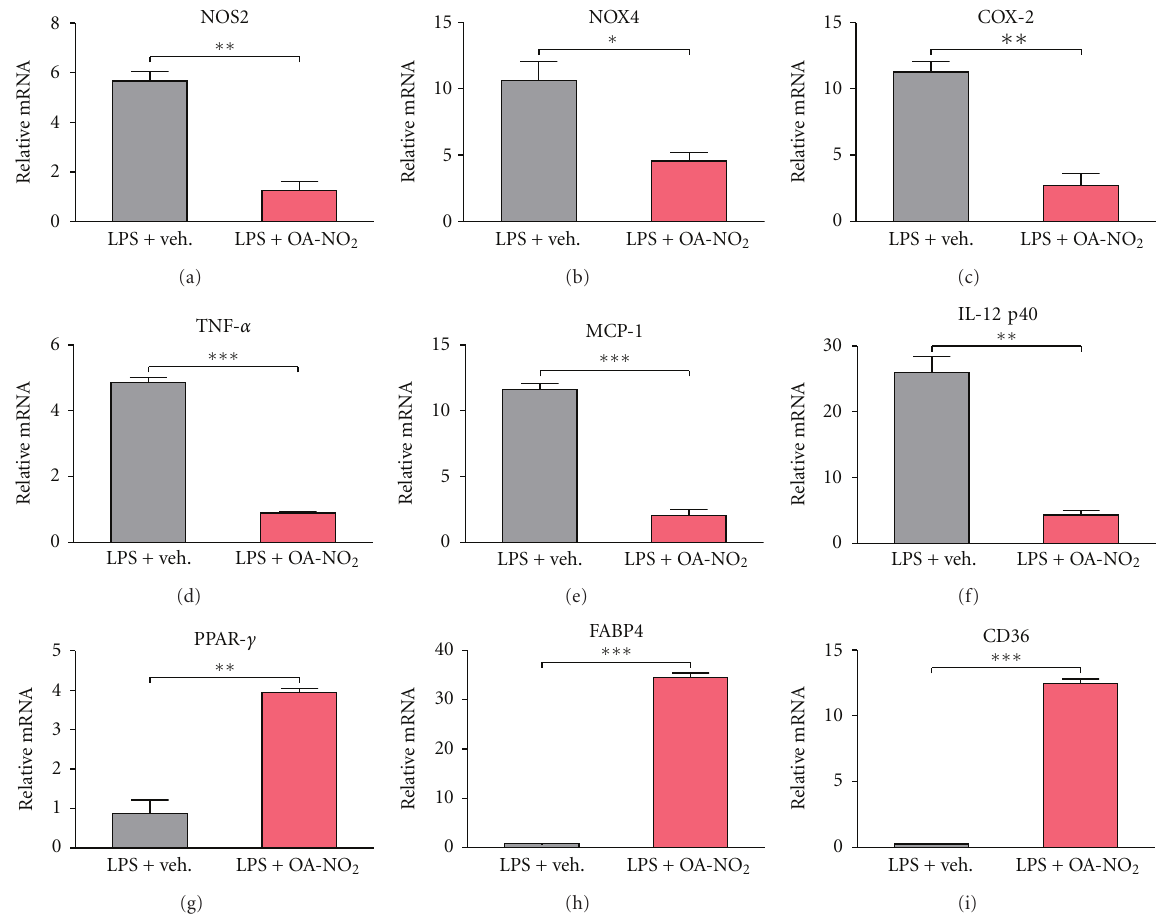
Figure 5: OA-NO 2 reduces inflammatory phenotype in LPS-activated alveolar macrophages. Induction of ALI by i.t. injection of LPS (50 μ g) was followed 30min later by i.t. administration (50 μ L) of OA-NO 2 (50 μ g) or vehicle (10% DMSO). After another 5.5 h BAL fluid was obtained. Alveolar macrophages were isolated from the BAL fluid and plated in DMEM + 10% FBS. After 1 h, RNA was isolated and expression of the indicated genes was determined using real-time PCR; results were normalized to values for the housekeeping genes glyceraldehyde-3-phosphate dehydrogenase (GAPDH) and 9s rRNA. Data are representative of one of two independent experiments with n = 6–8 mice per group; ∗ P < 0.05; ∗∗ P < 0.01; ∗∗∗ P <